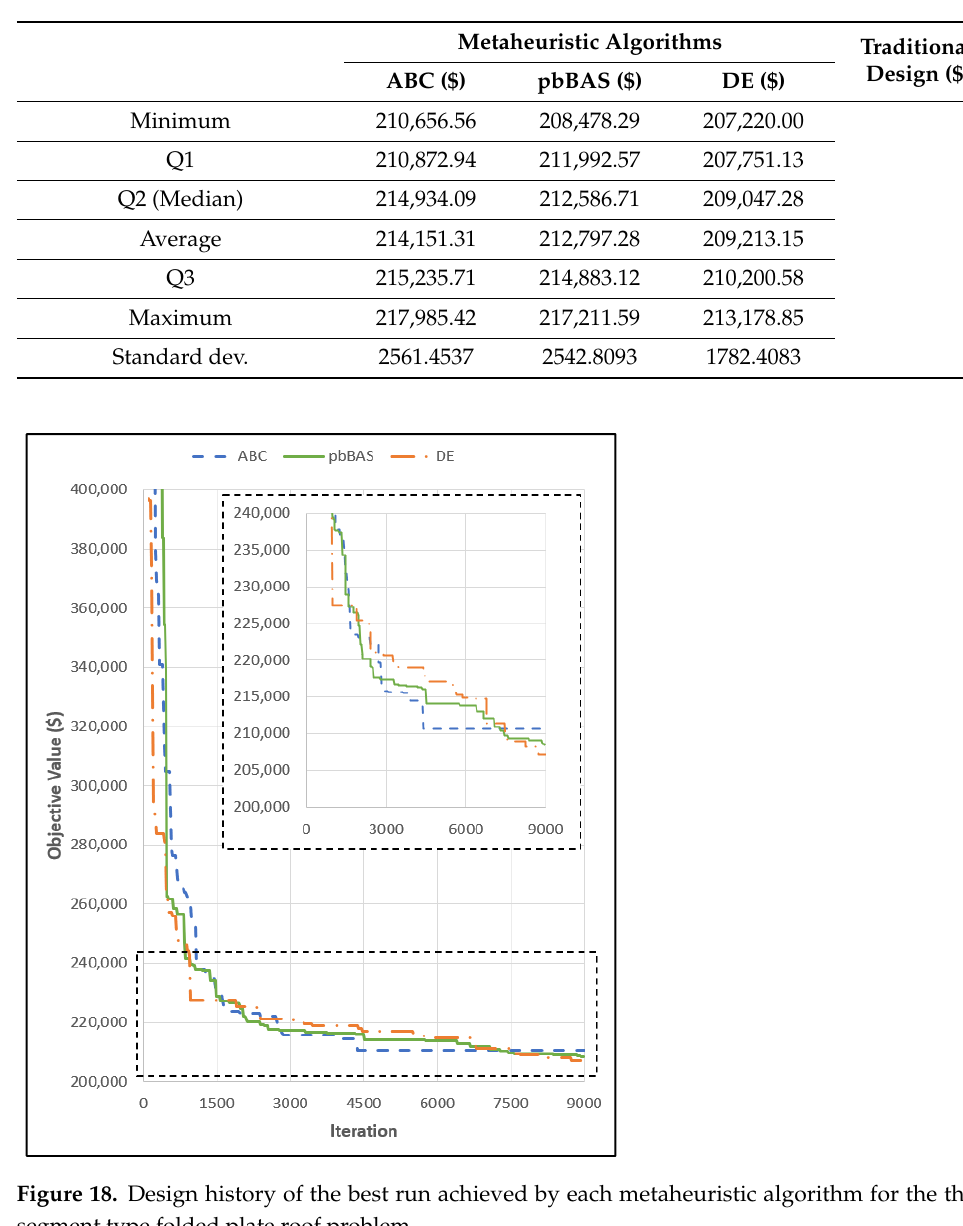
Figure 19. Design history of the sample average of the 10 runs achieved by each metaheuristic algo- rithm for the three-segment type folded plate roof problem.